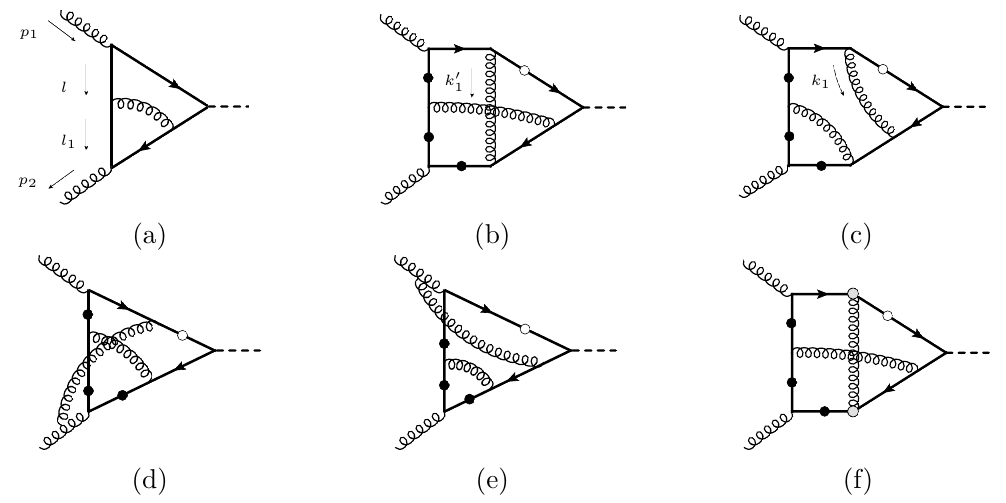
Figure 4 . The Feynman diagrams representing (a) the two-loop and (b)–(e) the three-loop corrections to the ggH amplitude with an additional eikonal gluon emitted by the soft quark. (f) the Feynman diagram with the effective soft gluon exchange, which represents the total QCD three-loop non-Sudakov double-logarithmic correction associated with the eikonal gluon emission, eq.